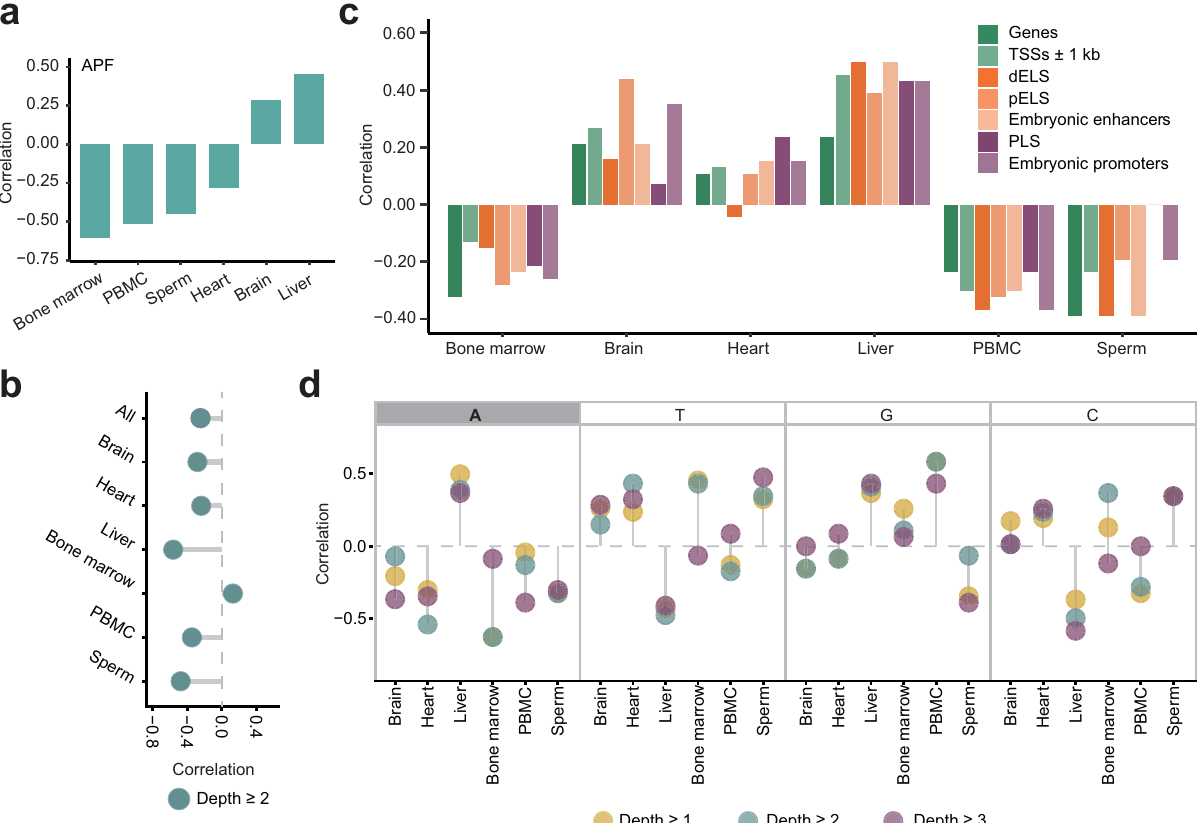
Fig.8|AssociationofvariousgenomicfeaturesofAPsitesandage.a Spearman correlation ( Y -axis) between global levels of AP sites (APF) and age in different tissues ( X -axis). b Spearman correlation ( X -axis) between age and fractions of sample-levelhotspotswithdepth ≥ 2acrossalltissuesorintheindividualtissues( Y - axis). c Spearman correlation ( Y -axis) between age and the odds ratios of associa- tion of AP sites with different genomic elements in different tissues ( X -axis). The